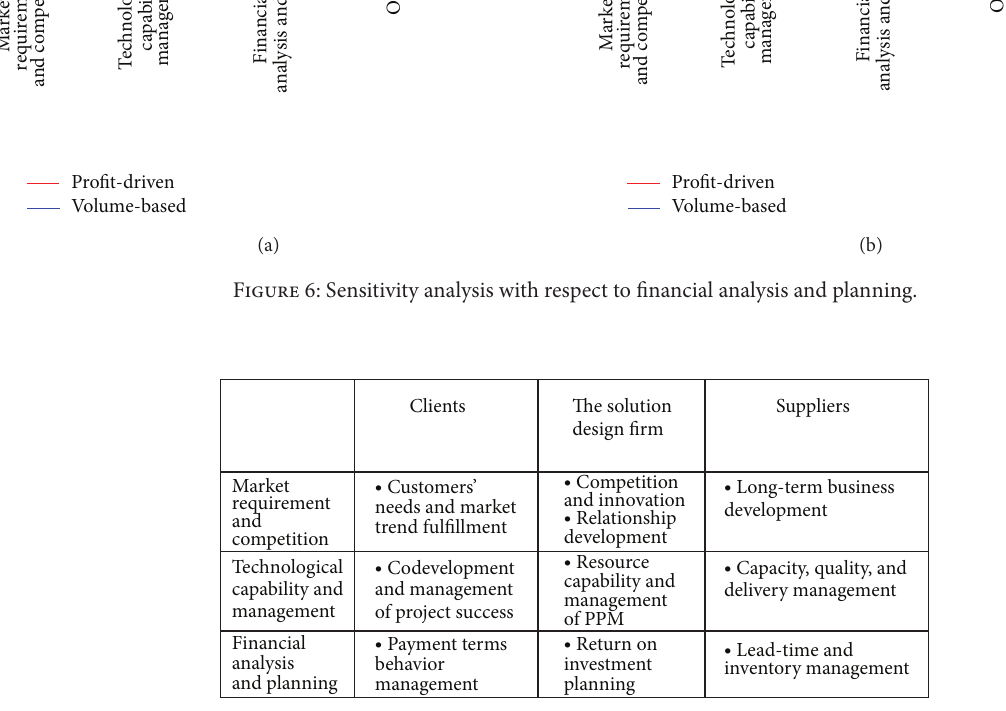
Figure 7: The matrix on factor